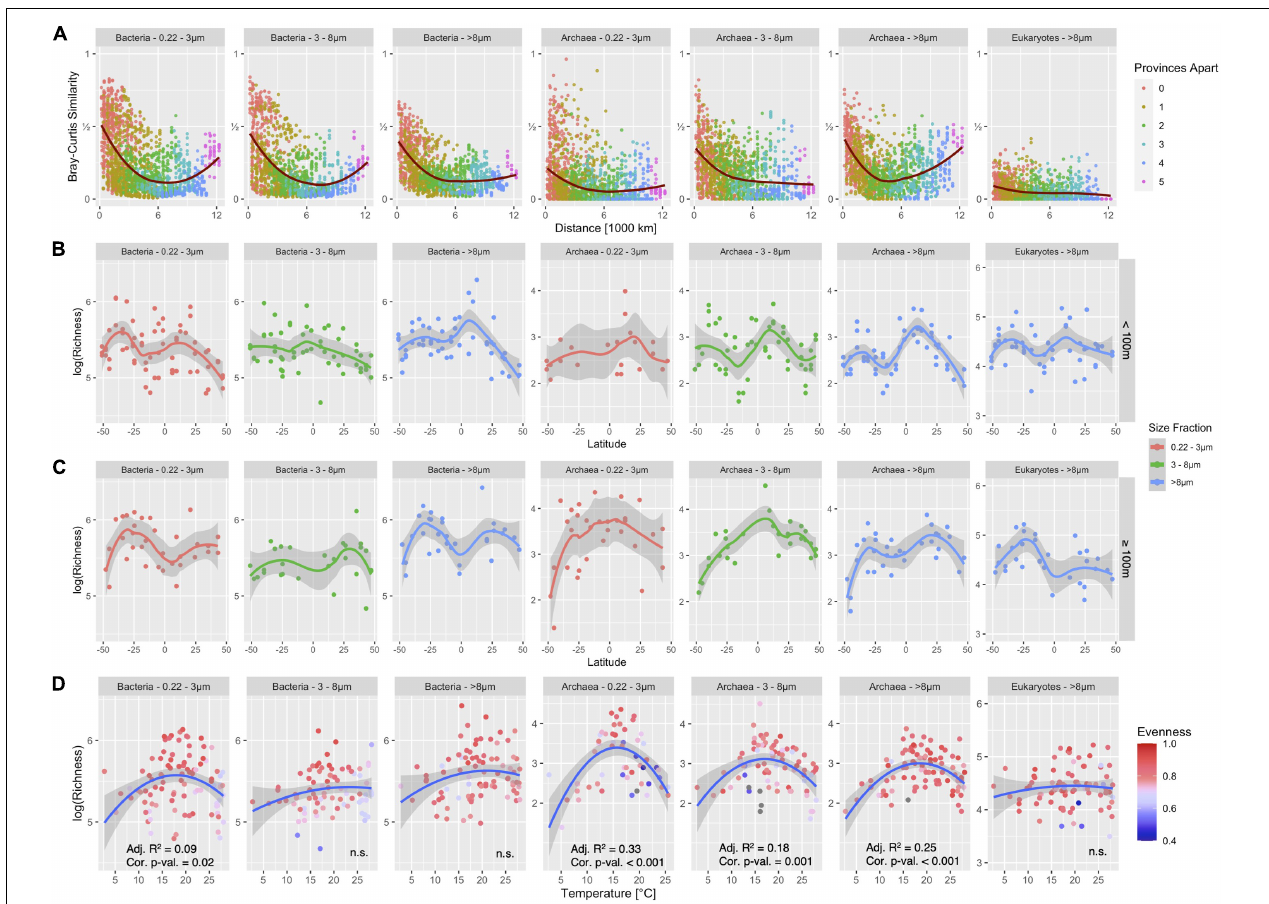
FIGURE 6 | Taxonomy independent analysis of alpha- and beta-diversity patterns of Bacteria, Archaea and Eukarya in the epipelagic of the Atlantic Ocean in three distinct size fractions for Bacteria and Archaea and the > 8 µ m size-fraction for Eukarya. (A) Distance-decay analyses using Bray-Curtis similarity. The red line shows a generalized additive model fit through data points. (B,C) Alpha-diversity in < 100 m depth (B) and ≥ 100 m depth (C) . Lines show loess-fit and gray shaded area its 95% confidence interval. (D) The relationship between richness and temperature is shown for Bacteria, Archaea, and Eukarya. Blue lines show second-order polynomial fit and the gray shaded area shows 95% confidence interval. The significance and R 2 of the fit are noted in the subplots; n.s., not significant. Sequences were obtained with the V4-V5